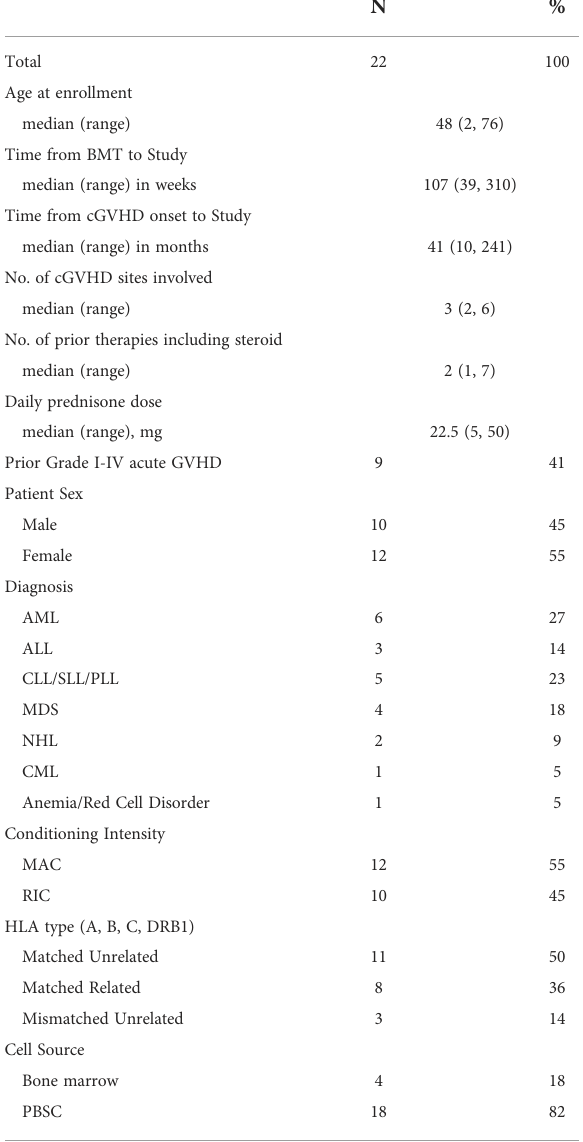
TABLE 1 Baseline patient